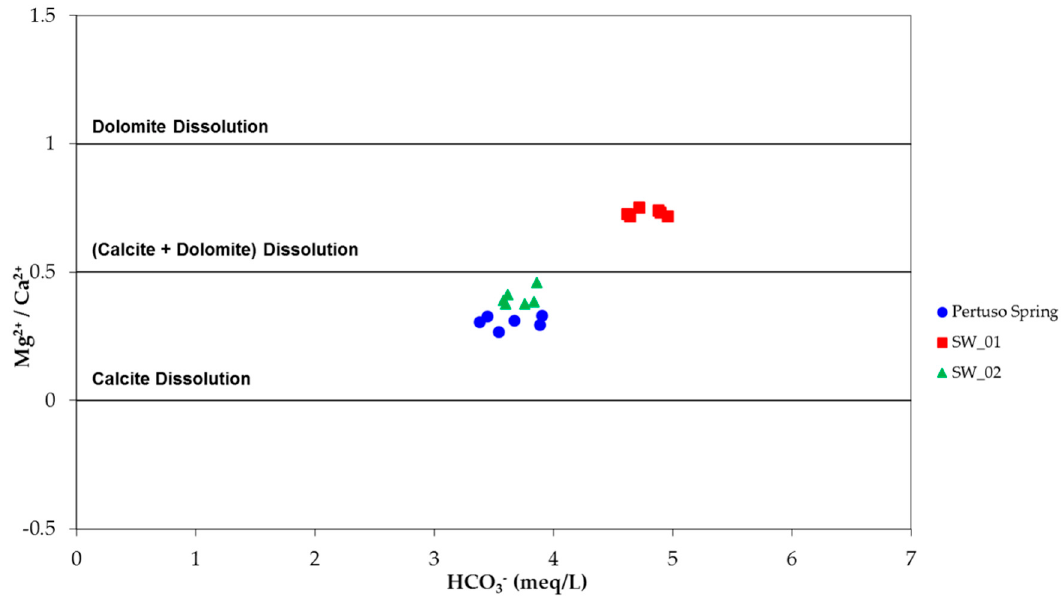
Figure 7. Mg 2+ /Ca 2+ ratio versus HCO 3 − in groundwater and surface water.